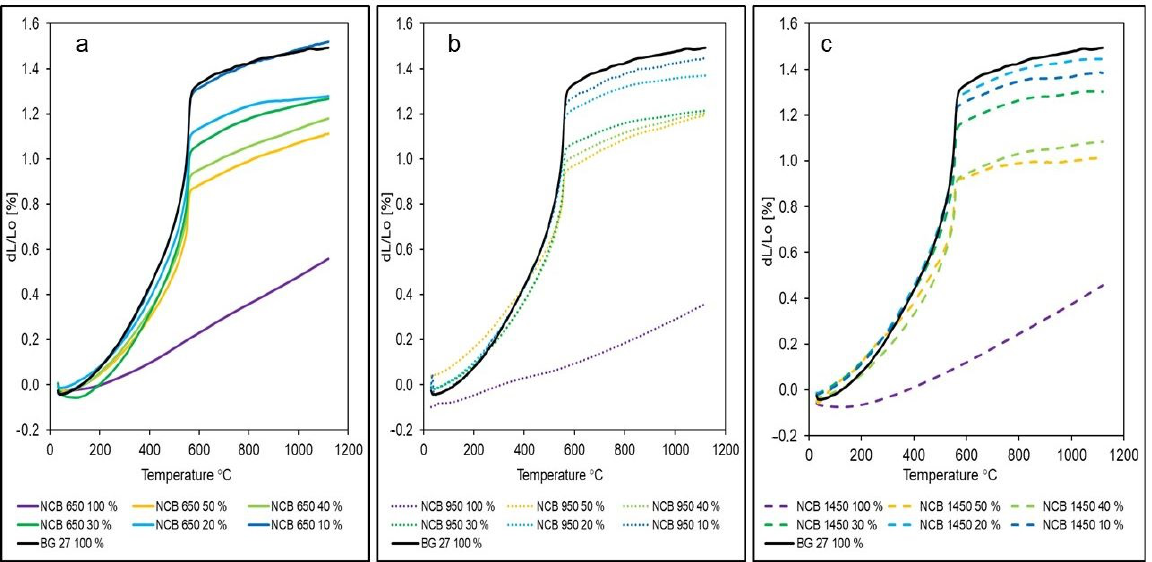
Figure 6. Detailed dilatation curves for individual NCB types compared with BG 27 100%: ( a ) NCB